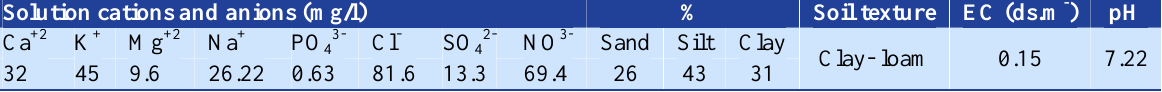
Table 1. Some physical and chemical properties of the studied soils Solution cations and anions